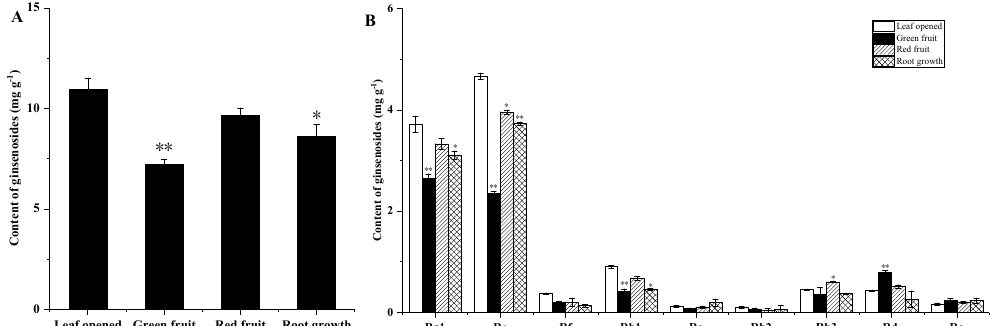
Figure 2. Ginsenoside content of roots from Panax ginseng during the different growth stages. The total ginsenoside content in the root ( A ) and the major individual ginsenosides in the root ( B ) were analyzed according to the leaf opened, green fruit, red fruit, and root growth stages. Vertical bars indicate the mean ± standard error from three independent experiments. The data are expressed as the mean ± SD. * indicated that the different growth stages are significantly different at the 0.05 level. ** indicated that the different growth stages are significantly different at the 0.01 level.